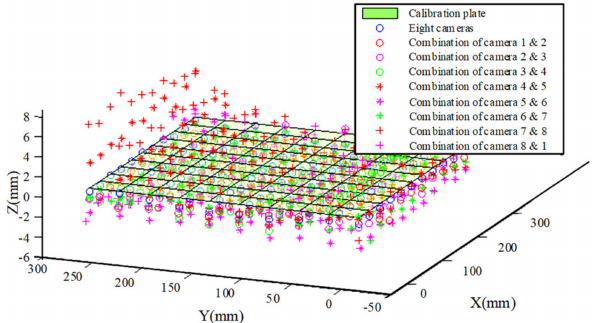
Figure 11. Underwater 3D reconstruction with combinations of adjacent cameras.